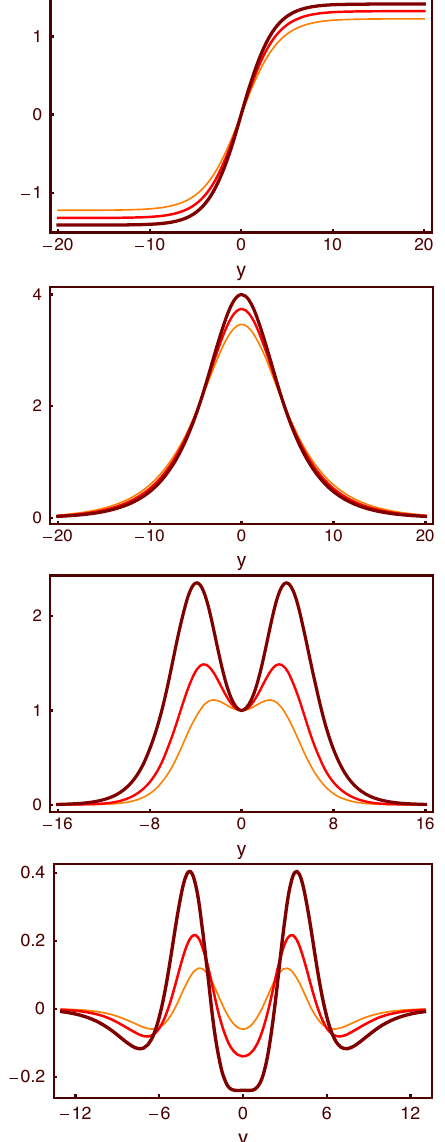
Fig. 1 From top to bottom, we depict the solutions φ( y ) and χ( y ) in Eq. (17), the warp factor associated to the warp function in Eq. (19) and the energy density (11) corresponding to these solutions for r = 0 . 4 with α = 0 . 5 , 1 , 1 . 5. The line thickness and color darkness increase as α increases